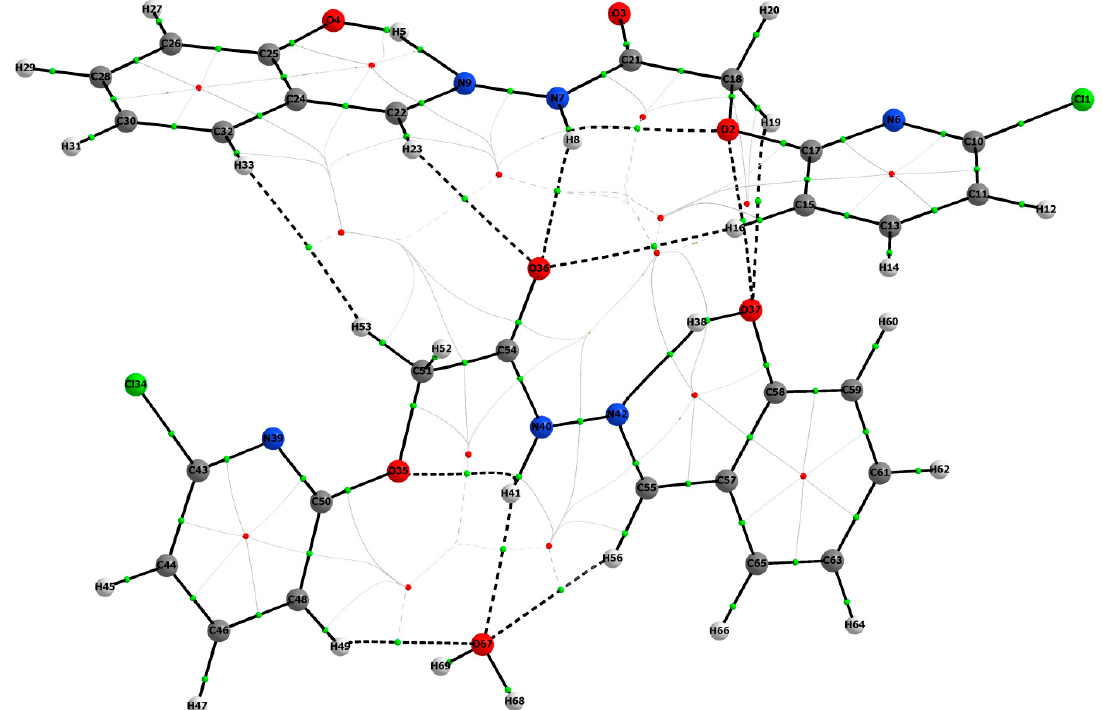
Figure 9. AIM based Schematic structure of HBPAH.